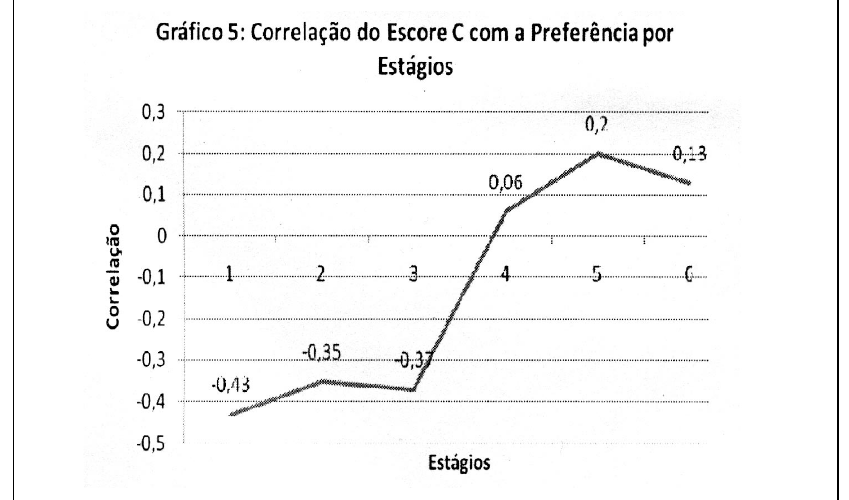
Figura 5 . Correlação do escore C com a preferência por estágios (Bataglia,